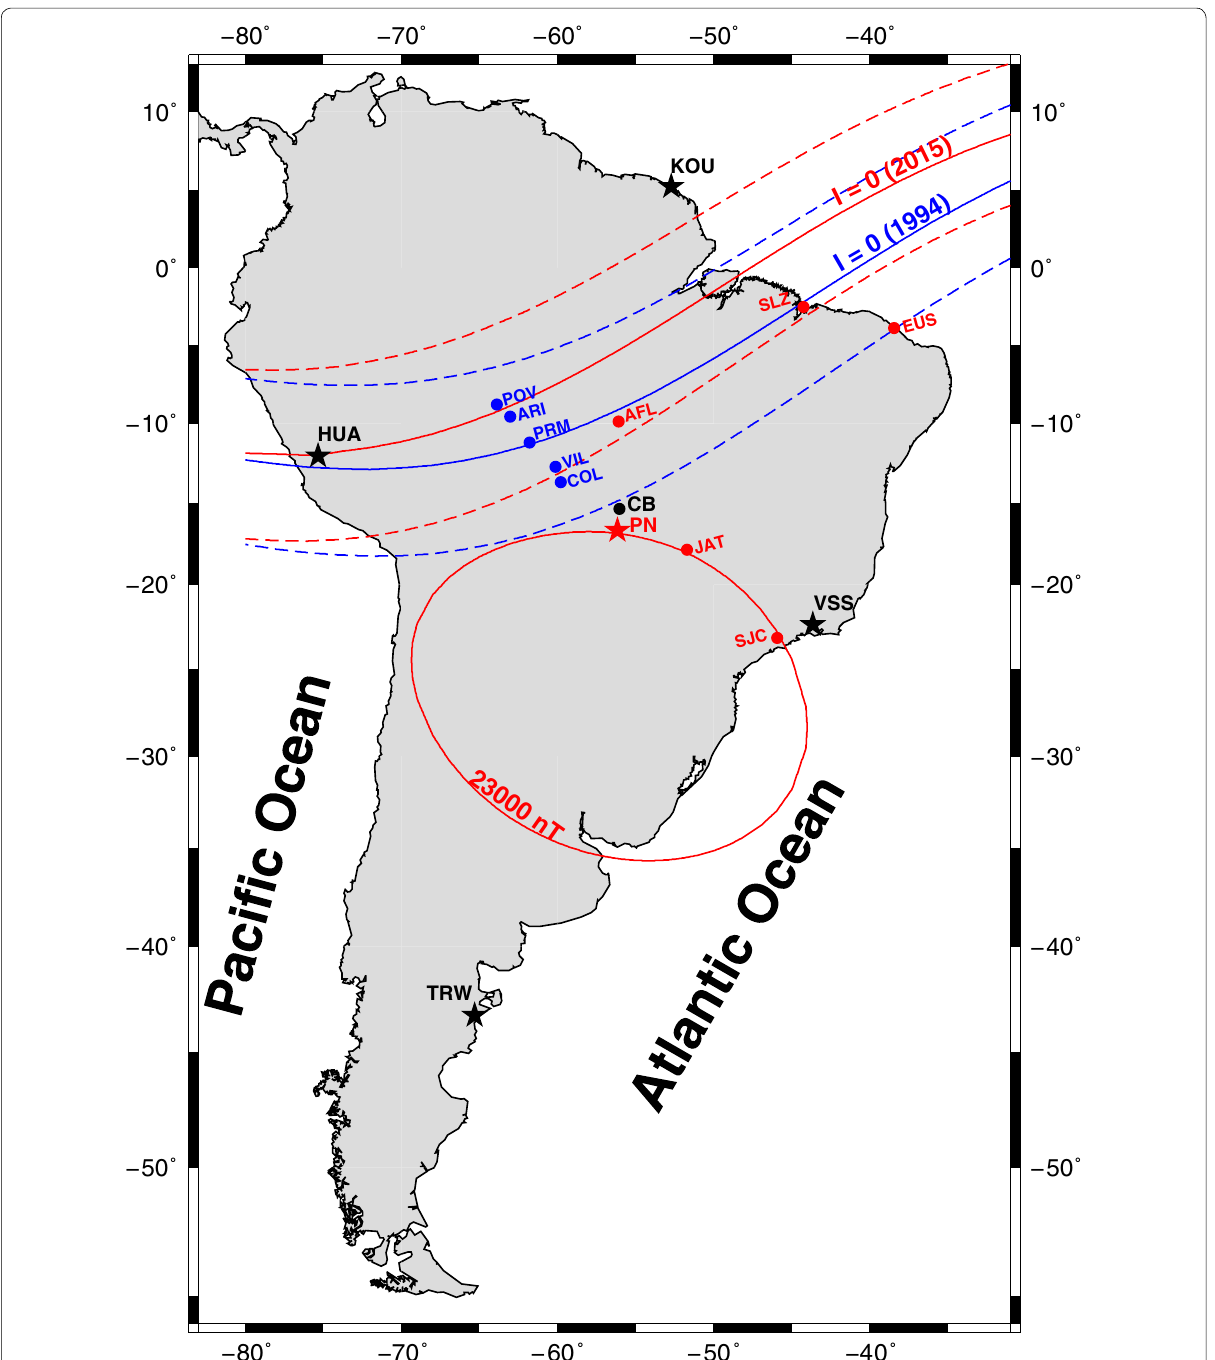
Fig. 1 Map of South American geomagnetic stations and the influence of the EEJ at different times and the SAMA at 2015. Sites and geomagnetic coordinates in blue are from the 1994 experiment, whereas sites and geomagnetic coordinates in red are from the 2015 experiment. The solid lines show the dip equator in both experiments, and dashed lines represent 10° dip angles. The 23,000 nT isoline outlines the SAMA in 2015. Site ± CB (Cuiabá) is nearly the same in both experiments. Location of the permanent geomagnetic observatories (KOU, HUA, VSS and TRW) and of the proposed new geomagnetic observatory (PN) is also